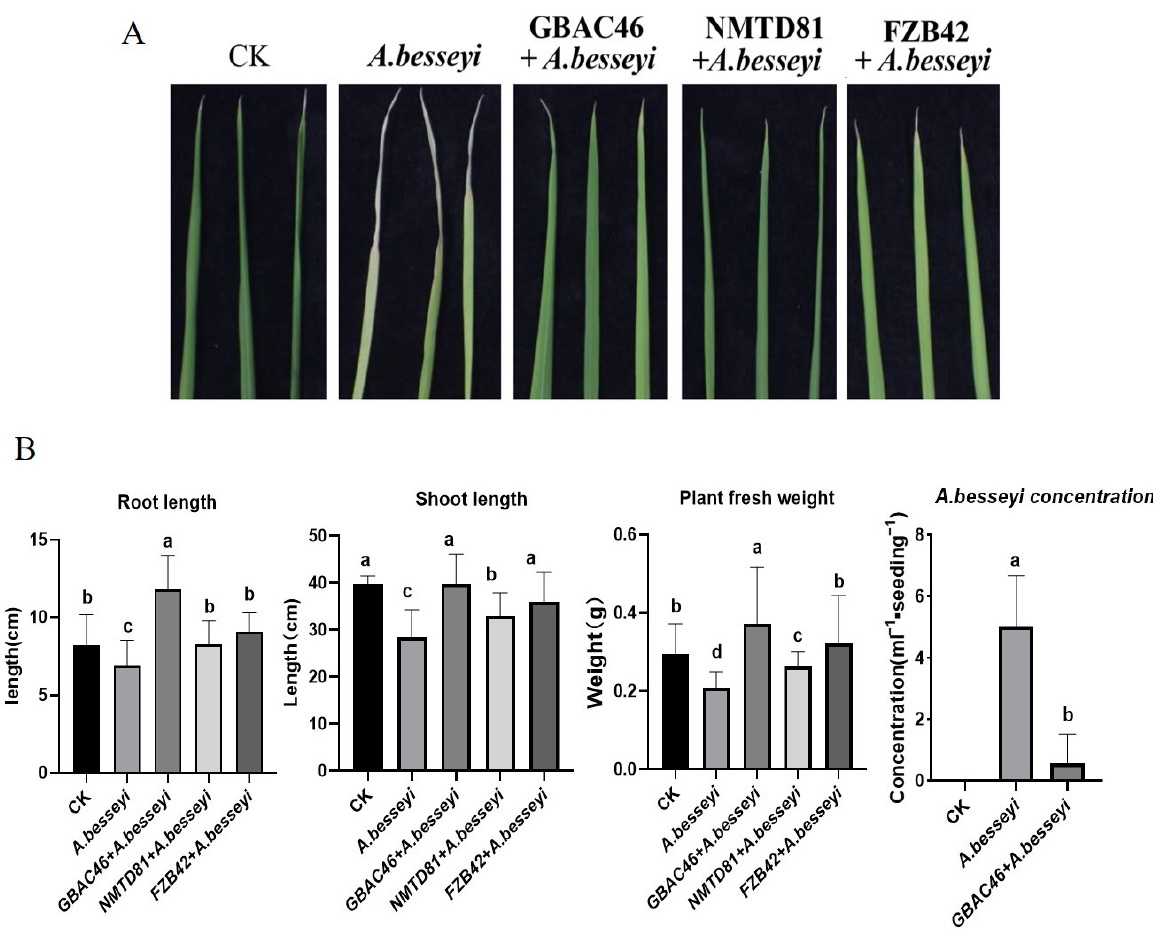
Figure 6. The effect of various Bacillus strains against A. besseyi -infested rice plants in a greenhouse experiment. The photographic representation of the effect of the selected strains on the infested rice plants ( A ). The rice growth promotion parameters, such as root and shoot length, plant fresh weight, and the detection of several A. besseyi nematodes from rice seedlings, after being treated with the selected strains ( B ). The error bars indicate the mean standard deviation of each treatment when replicated three times. Significant differences are indicated by the letters above the columns. Fisher’s LSD test was used to determine significant differences between treatments at p ≤ 0.05.